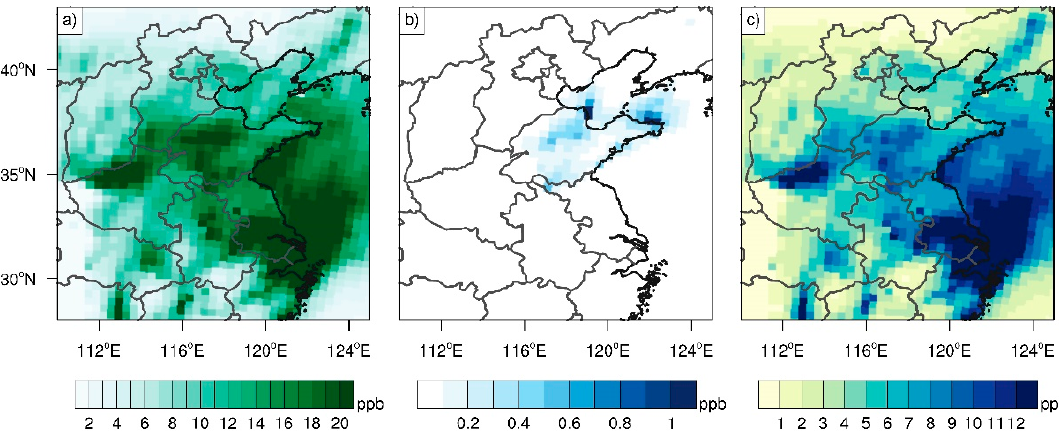
Figure 8. MDA8 ozone concentrations (units: ppb) caused by ( a ) biogenic emissions, ( b ) isoprene emissions in Shandong Province, and ( c ) isoprene emissions outside Shandong Province from July 18 to July 28, 2017.